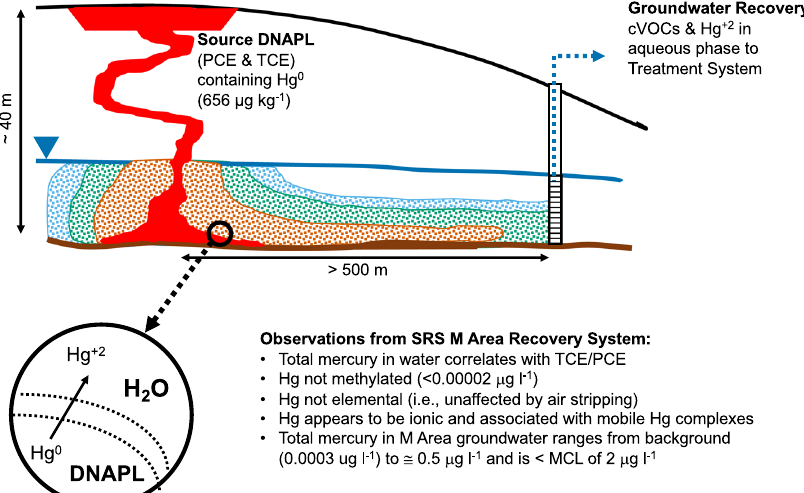
Fig. 2 Transport of elemental mercury in DNAPL and aqueous transport of oxidized mercury when DNAPL is naturally depleted in oxidizing conditions of aerobic aquifer 60 . Conceptual model explaining why higher than background mercury concentrations are detected in groundwater recovery wells in the M Area of SRS. DNAPL (solid red) comprised of PCE and TCE and co-disposed Hg 0 travels downward via density driven fl ow in a tortuous path through the vadose zone (white), below the water table (blue triangle), then through the aquifer until constrained by fi ne grain aquifer materials. Hg 0 oxidation at the DNAPL:H 2 O interface occurs under bulk aerobic geochemical conditions and complexes of oxidized ionic mercury (e.g., HgCl 2 0 ) are formed which are soluble in groundwater. The mobile aqueous phase complexes travel with groundwater and are collected in monitoring and recovery wells. Vermillion, bluish green, and sky blue cross hatched areas indicate qualitative cVOC concentration contours.